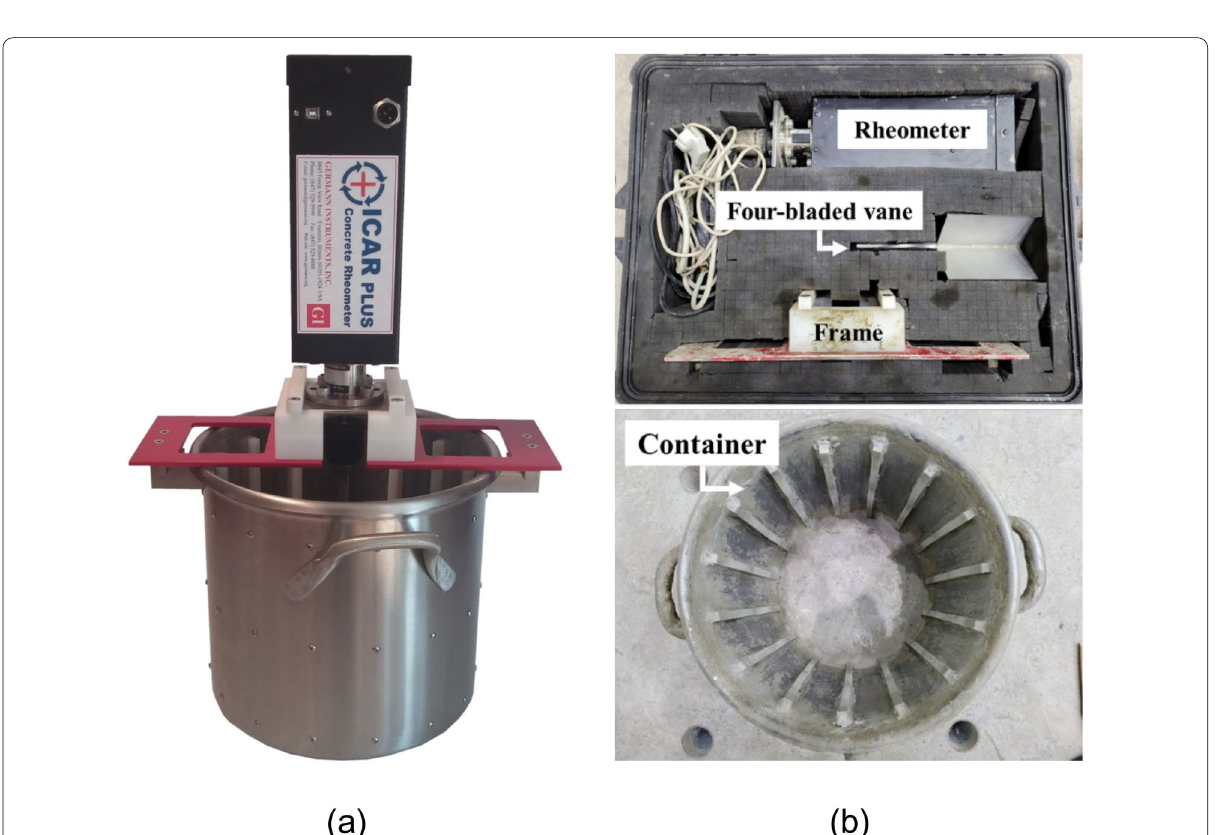
Fig. 5 ICAR rheometer (Ramakrishna & Sundararajan, 2005): a entire system; b detailed